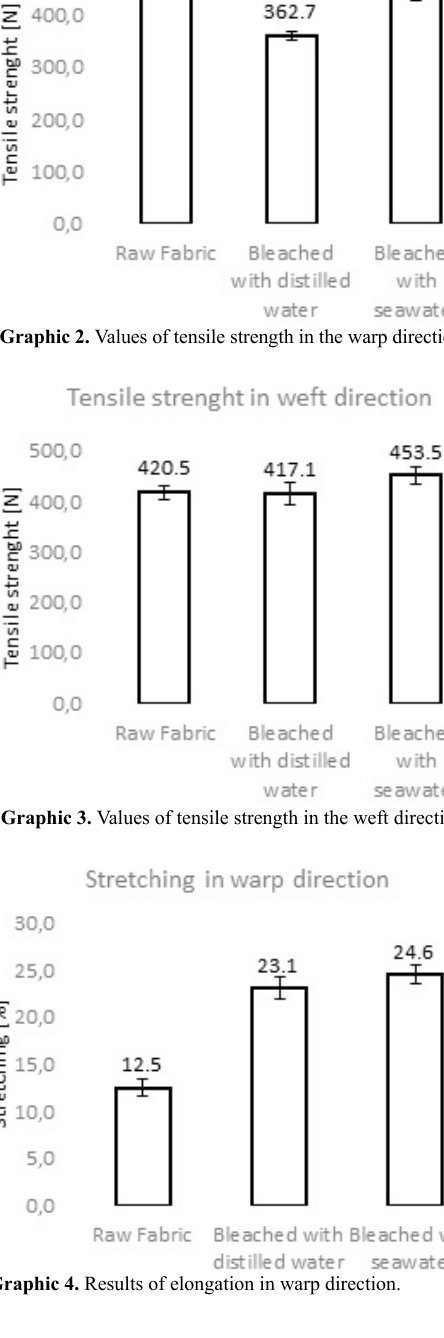
Table 2. Solvents characterization (Results of physico-chemical properties).